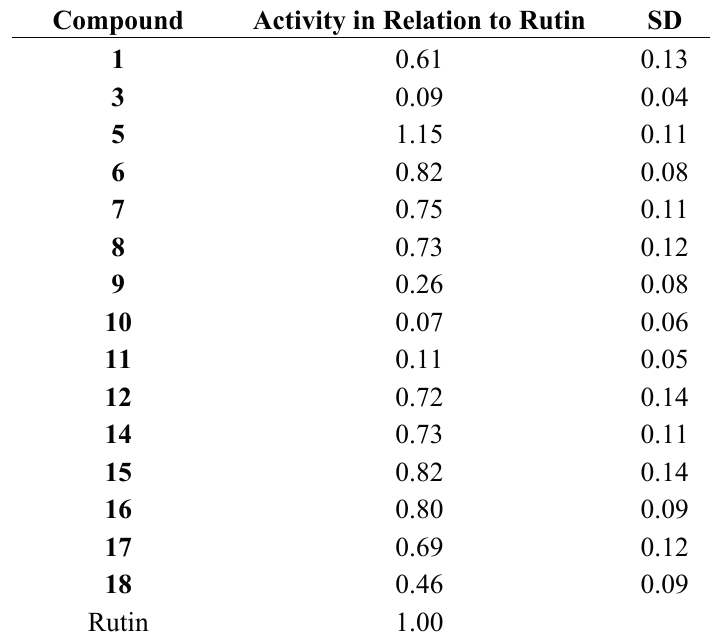
Table 6. The DPPH scavenging activity of isolated flavonoids, expressed in relation to the activity of